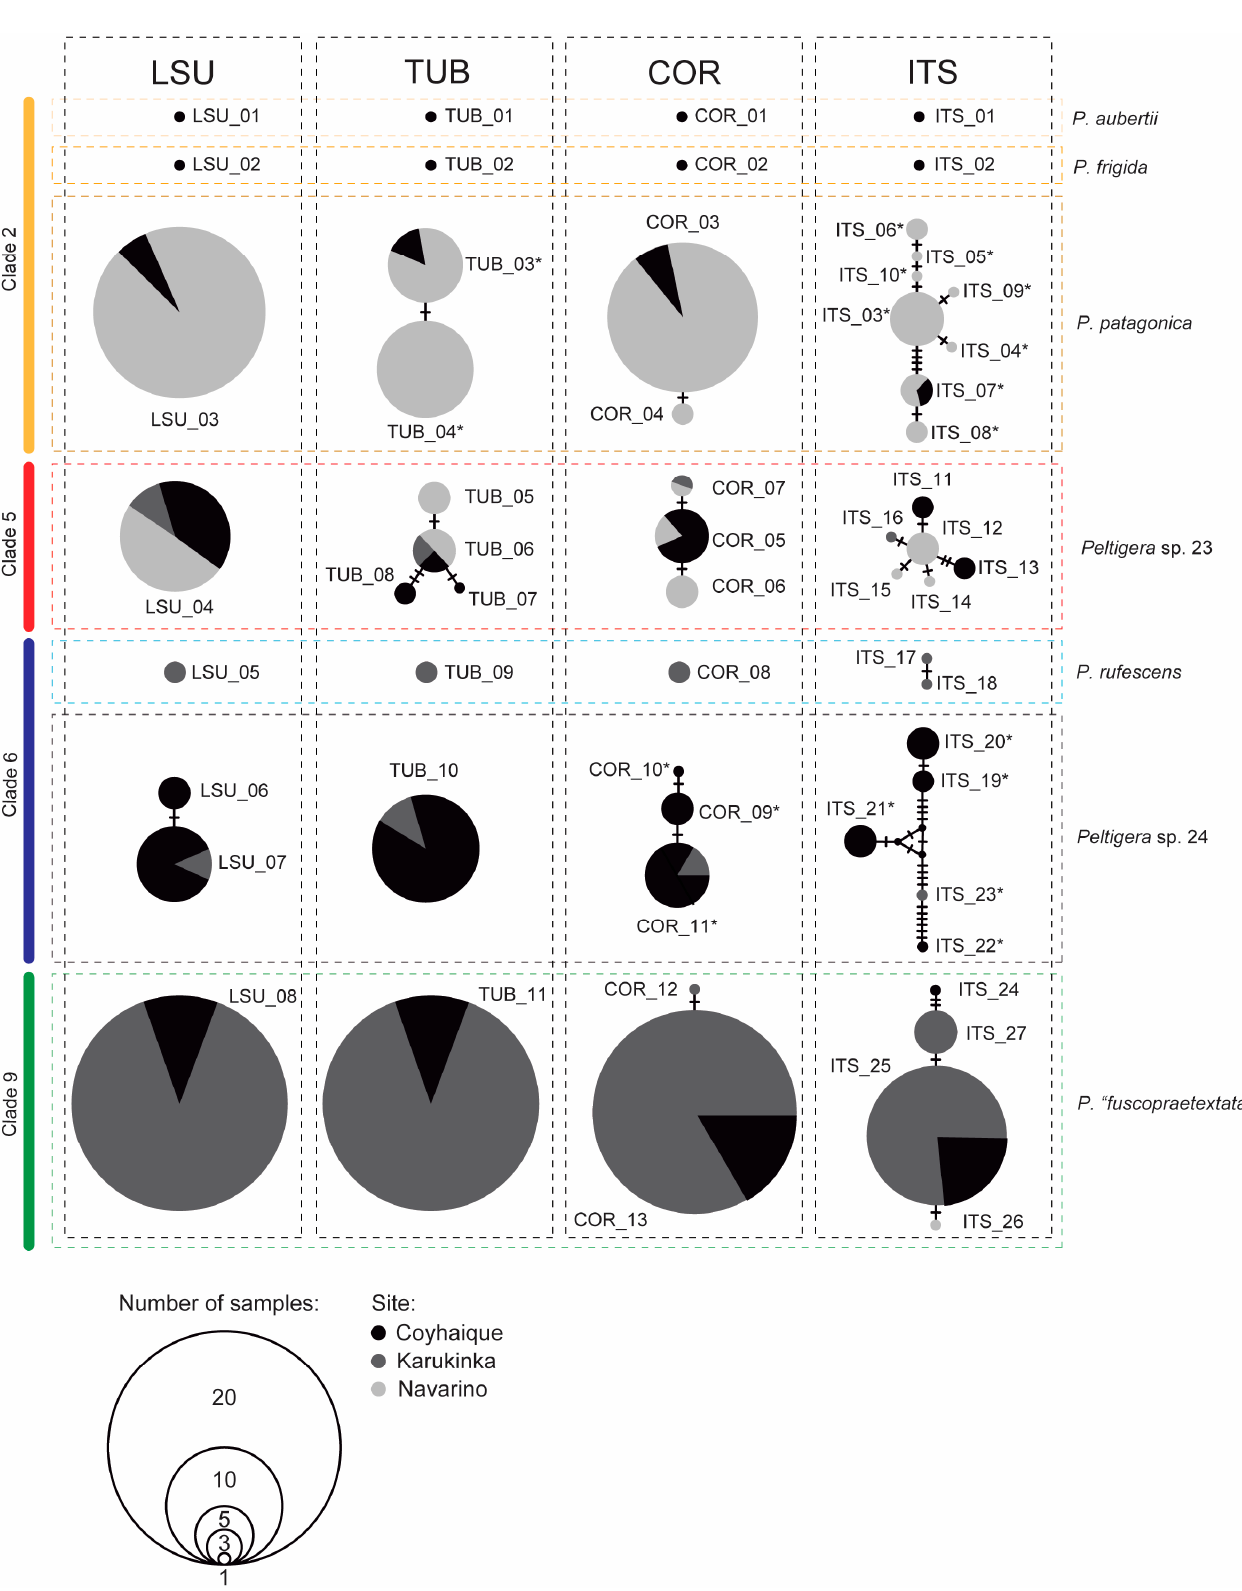
Figure 4. Networks of Peltigera mycobiont haplotypes based on four fungal markers: LSU, β -tubulin (TUB), COR3 (COR), and ITS. The graphical representation of the number of samples and colors of the sites are shown in the lower left corner. Asterisks indicate sequences of the markers yielding percentage identity values less than 99%, according to BLASTn (Table S2).